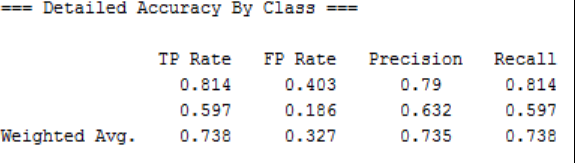
Figure 13. Diagnosis of diabetes using decision tree.